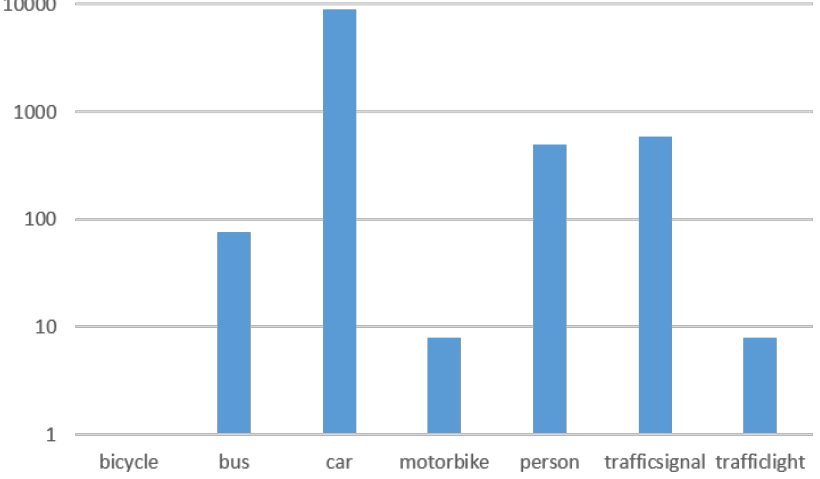
Figure 5. Number of annotations per class from the second set of automatic annotated images. There were 10,167 annotated objects captured with a low-resolution SONY camera with a 640 × 480 resolution. Note there is only 1 annotation for the bicycle class.